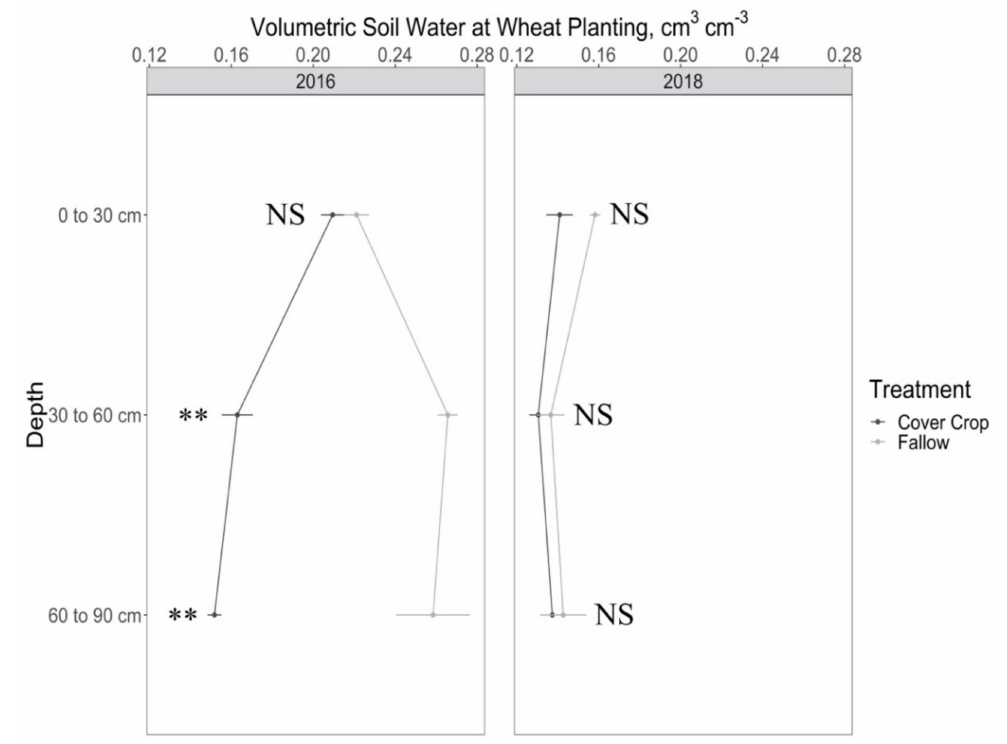
Figure 2. Volumetric soil water content at 2016 and 2018 wheat planting in a field experiment (T1) located at the Southwestern Colorado Research Center in Yellow Jacket, CO. Significance of orthogonal contrasts between cover crop and fallow treatments for each depth are displayed (NS means not significant, ** indicates p <